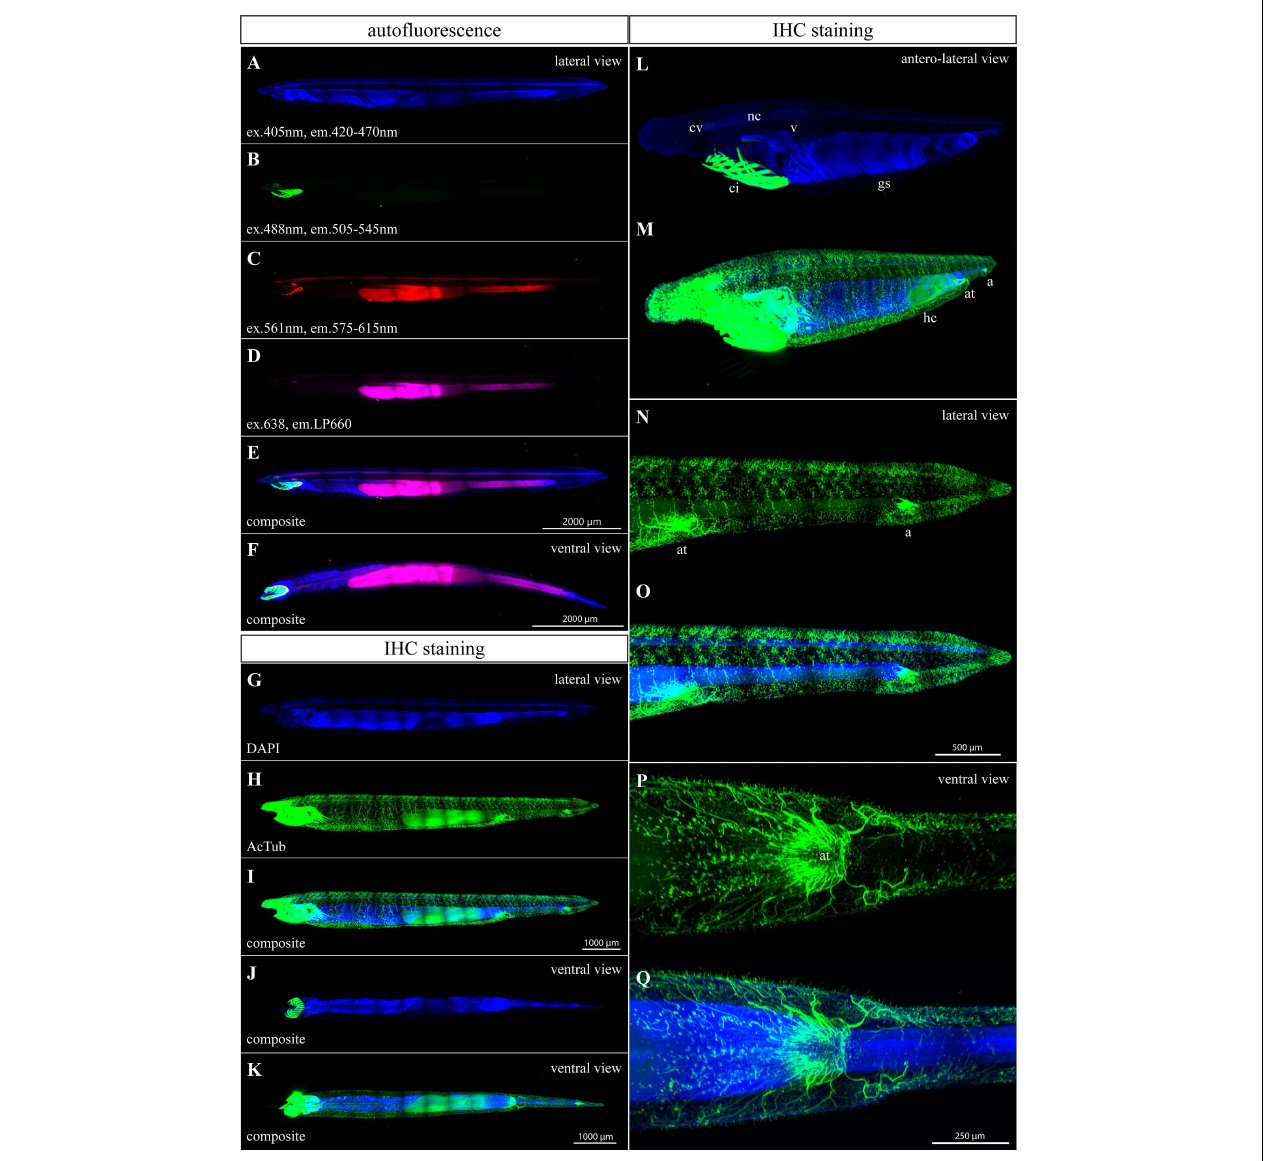
FIGURE 3 | Autofluorescence and anti-acetylated- α -tubulin staining of a 3-month-old amphioxus juvenile. (A) DAPI staining of a specimen examined for autofluorescence. (B–F) Individual scans of juvenile autofluorescence emitted in green (B) , red (C) , and magenta channels (D) . (E,F) Composite image of previous scans from the lateral (E) and ventral view (F) . The specimen scanned for autofluorescence was about 8 mm long. (G) DAPI staining of the specimen in (H–I) . (H–N) IHC staining of acetylated tubulin. The stained juvenile was 8 mm long. (J,K) Ventral view of immunostained juvenile. (L,M) Anterolateral view of the anterior portion of immunostained juvenile. Differential adjustment of brightness/contrast of the green channel was required to demonstrate the intensity of strong endogenous GFP signal in cirri (L) compared with the staining of acetylated tubulin (M) . (N,O) Detail of the posterior portion of immunostained juvenile, from the lateral view. (P,Q) Ventral view of atriopore innervation. All fluorescence images represent 3D reconstruction of the whole body mass. The regular areas of low signal intensity in the images are caused by lower intensity of the light falling on the camera chip margins during the imaging of the tiles. a., anus; at., atriopore; ci., buccal cirri;